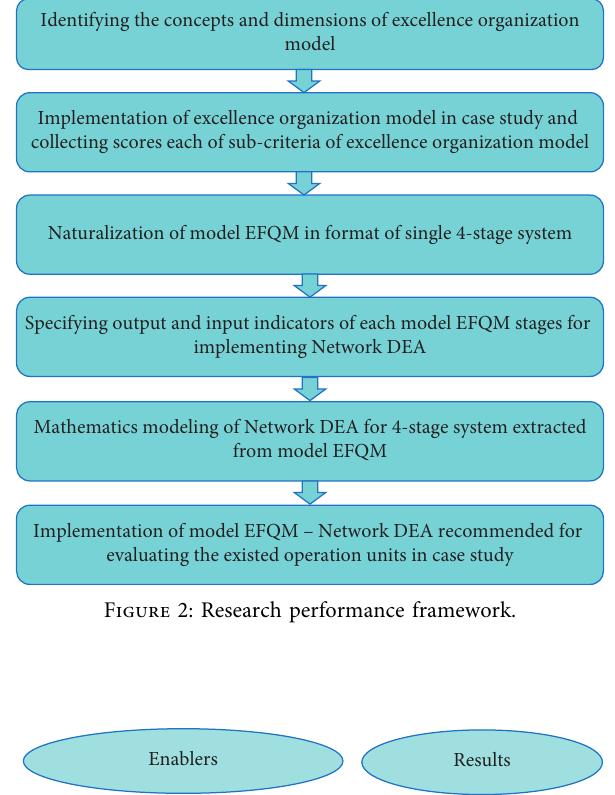
Figure 2: Research performance framework.